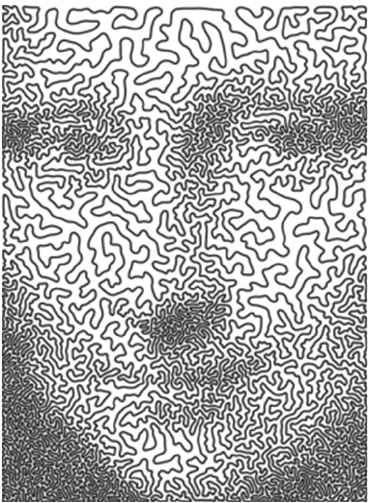
Figure 19: Mona Lisa as a continuous-line drawing